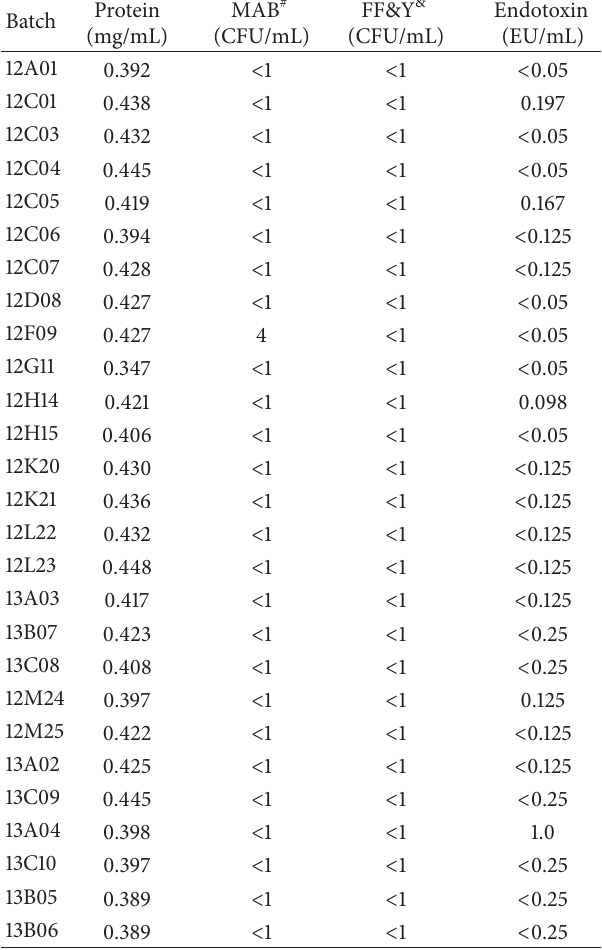
Table 1: Quality attributes of evaluated batches of